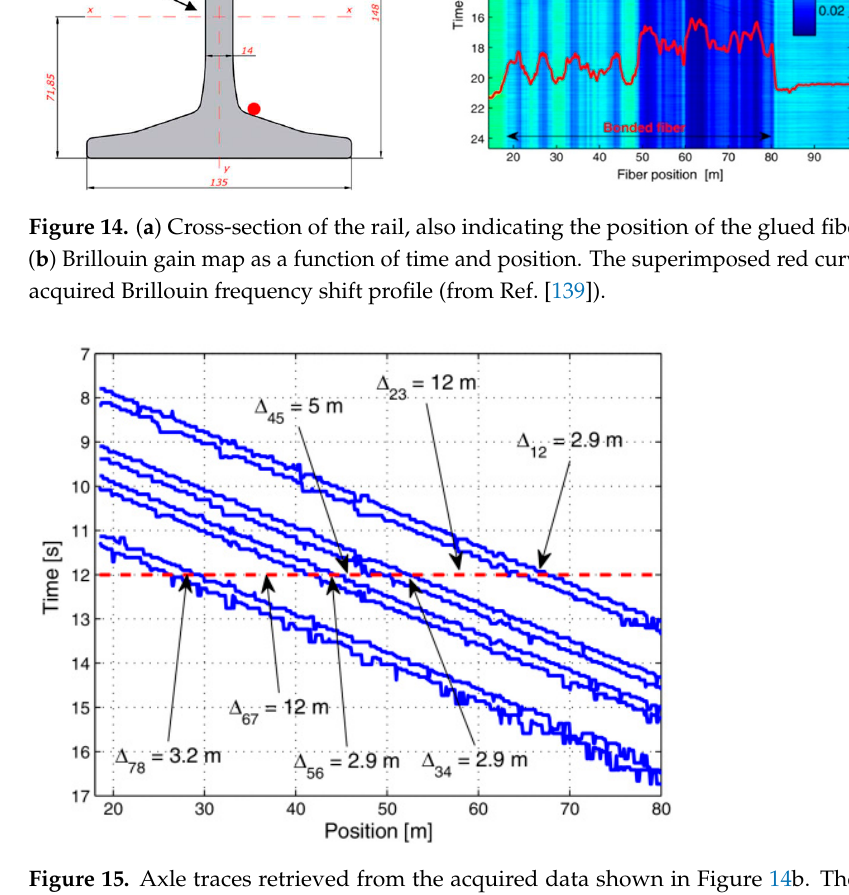
Figure 15. Axle traces retrieved from the acquired data shown in Figure 14b. The estimated axle distances are also reported. The horizontal dashed line indicates the time instant chosen for the axle distance estimation (from Ref. [139]).